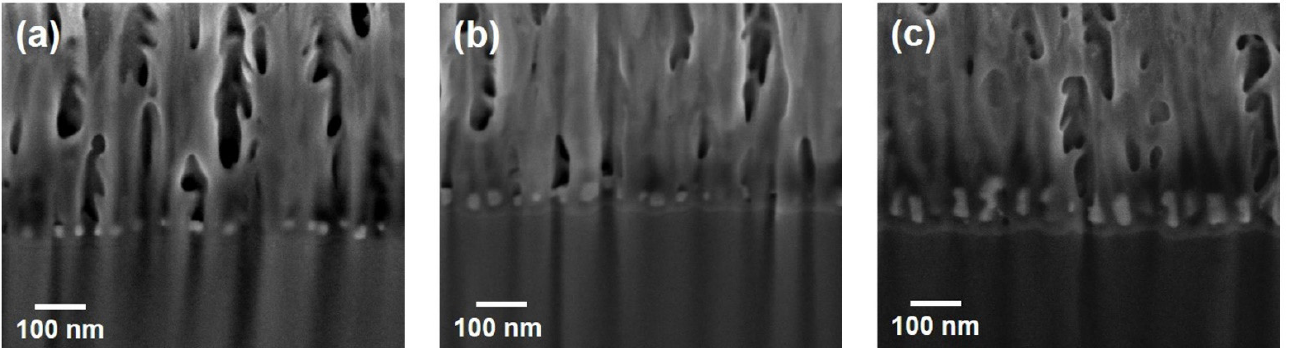
Figure 2. Typical cross-sectional SEM micrographs of Ag-AAO substrates with Ag-deposition cycles of ( a ) 6, ( b ) 13, and ( c ) 39. of ( a ) 6, ( b ) 13, and ( c ) 39.